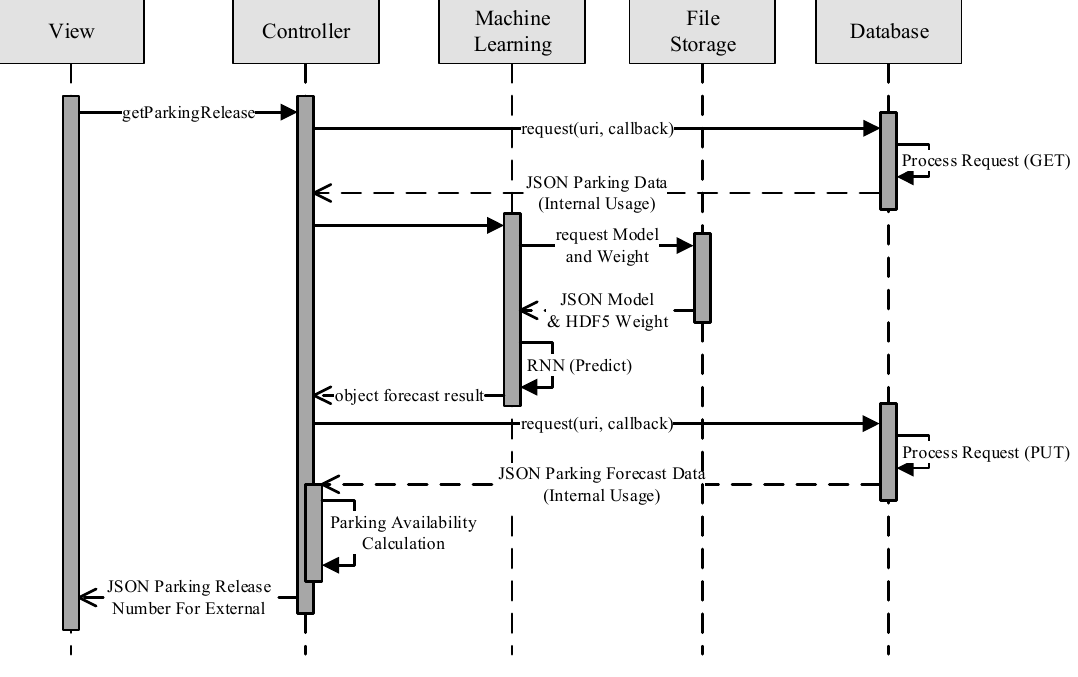
Figure 11. Sequential diagram of forecasting process.